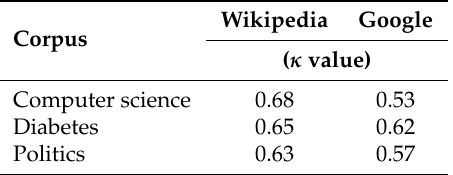
Table 13. κ value for seed URLs from Wikipedia and Google for the three corpuses.